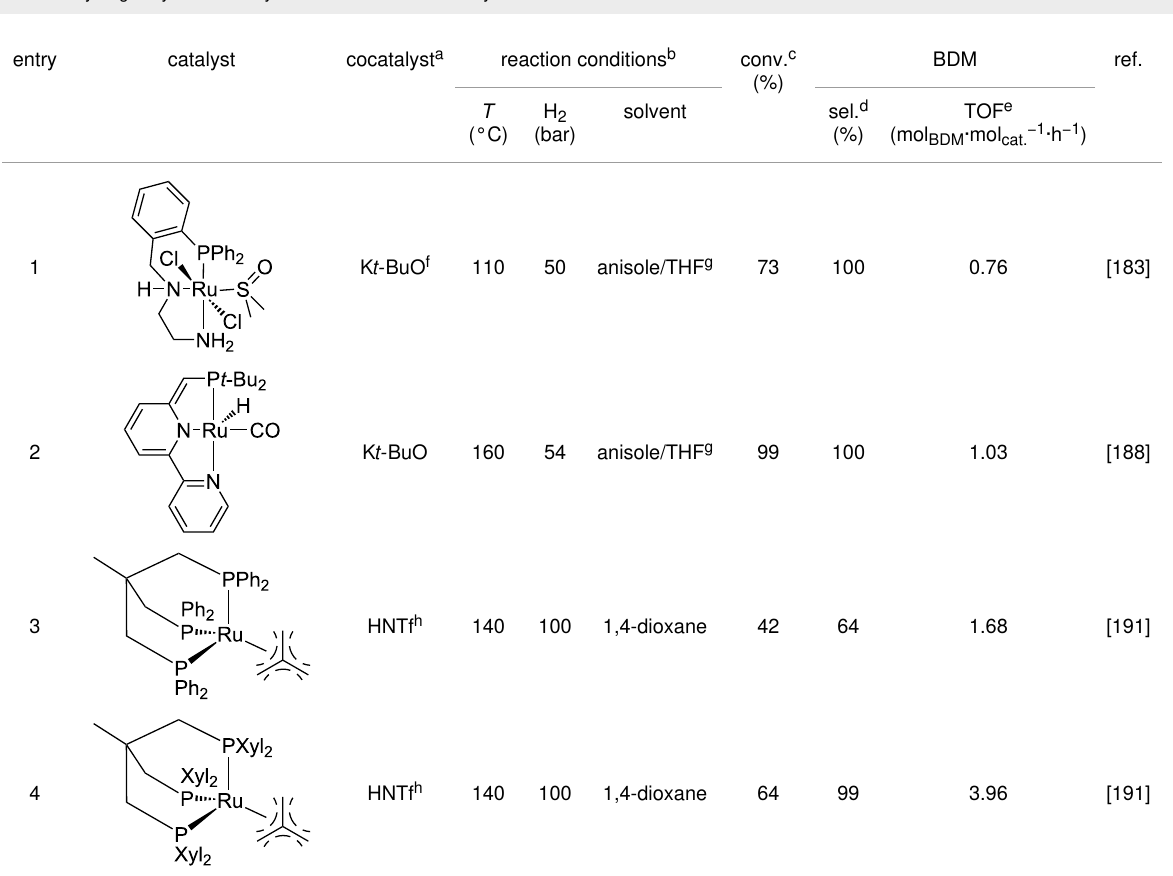
Table 1: Hydrogenolysis of PET by soluble Ru molecular catalysts.